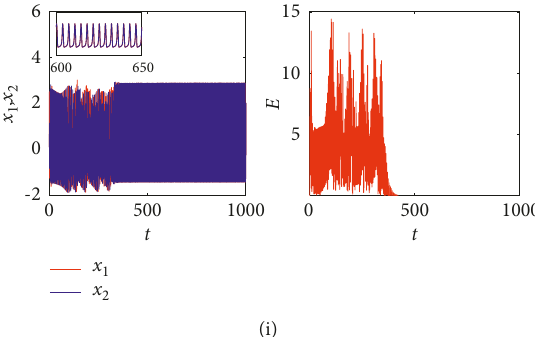
Figure 16: The time series of membrane potentials x (red line) and x (blue line), and error functions of the coupled model at case 5 1 2 (periodical and spiking neurons). For (a) periodical firing synchronization with τ � 0 . 01 and D � 2; (b) bursting firing synchronization with τ � 0 . 01 and D � 14; (c) bursting firing synchronization with τ � 0 . 1 and D � 2; (d) spiking firing synchronization with τ � 0 . 1 and D � 9; (e) quiescent state synchronization with τ � 0 . 1 and D � 13; (f) spiking firing synchronization with τ � 0 . 3 and D � 3; (g) quiescent state synchronization with τ � 0 . 3 and D � 4; (h) quiescent state synchronization with τ � 0 . 5 and D � 3; and (i) periodical firing synchro- nization with τ � 3 and D � 4. The initial values are selected with (0.1, 0.01, 1.05, 0.1, 0.01, 1.05).